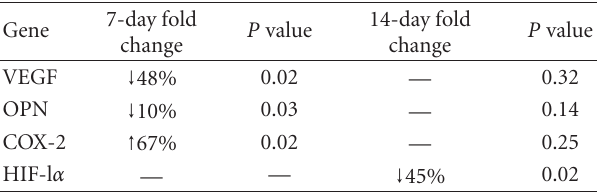
Table 2: Changes in mRNA levels with perfusion flow (osteoblast cultures) at 1 and 2 days.